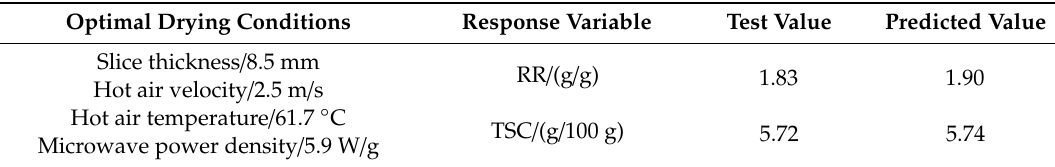
Table 5. Predicted and test values of response variables under optimal